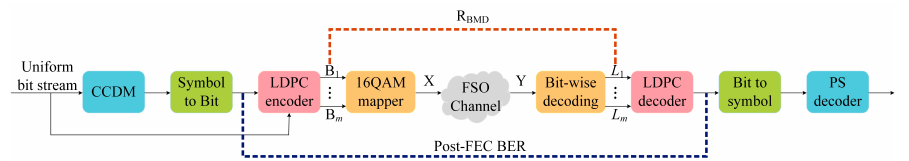
Figure 2. Simulation. An example for